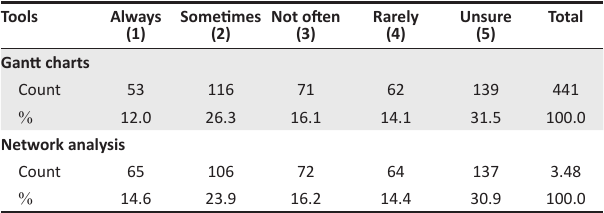
TABLE 3: Participants’ responses on the use of time management